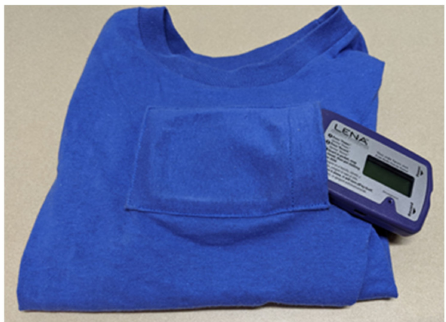
Figure 4. The Language Environment Analysis System (LENA Research Foundation, 2015) alongside the specially made t-shirt. The chest pocket secures the LENA throughout the day with a snap